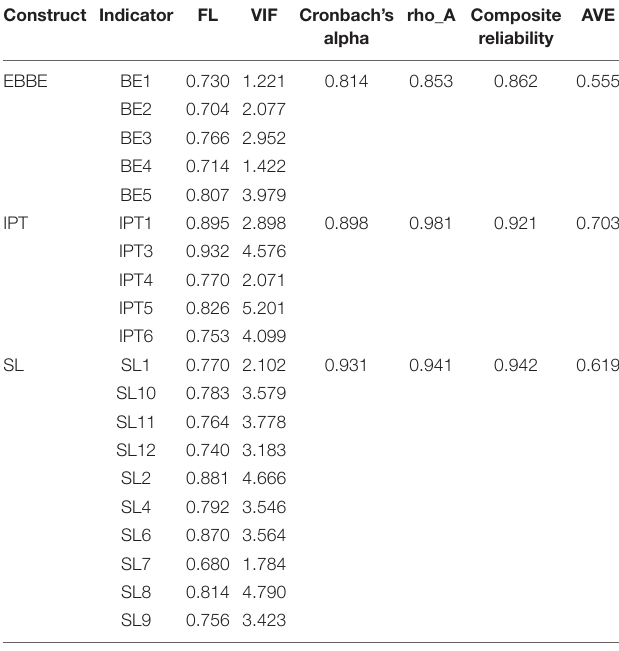
TABLE 1 | Reliability and convergent validity of the study constructs. Construct Indicator FL